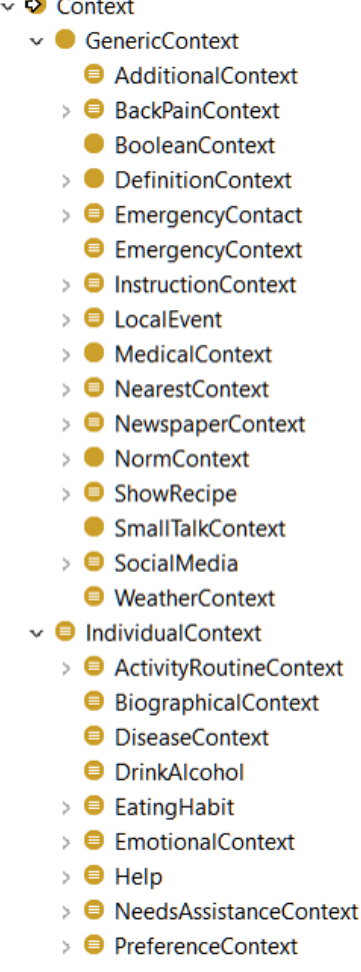
Figure 4. Upper-level classes for the topic hierarchy